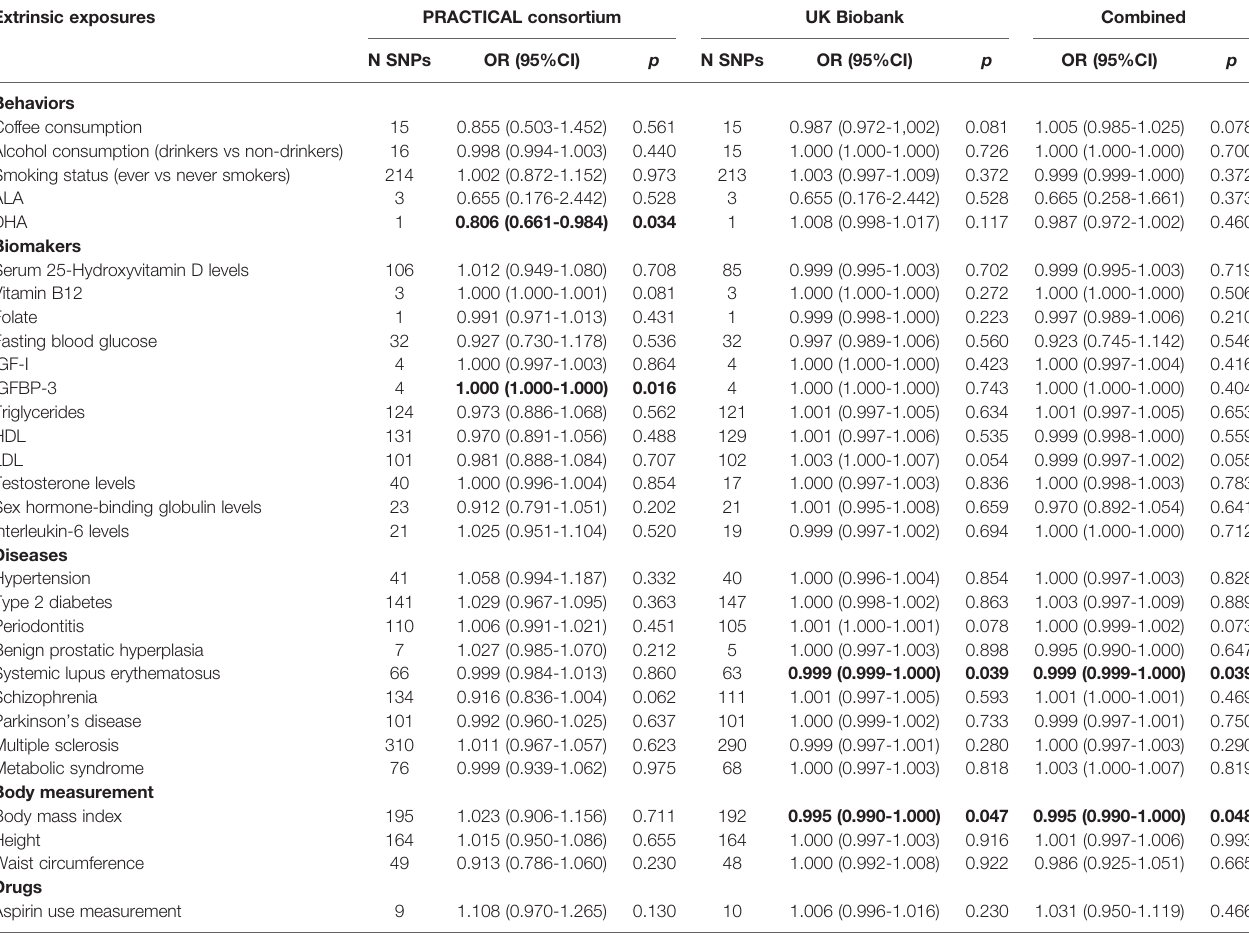
TABLE 2 | Mendelian randomization analyses of the association between extrinsic exposures and prostate cancer risk. Extrinsic